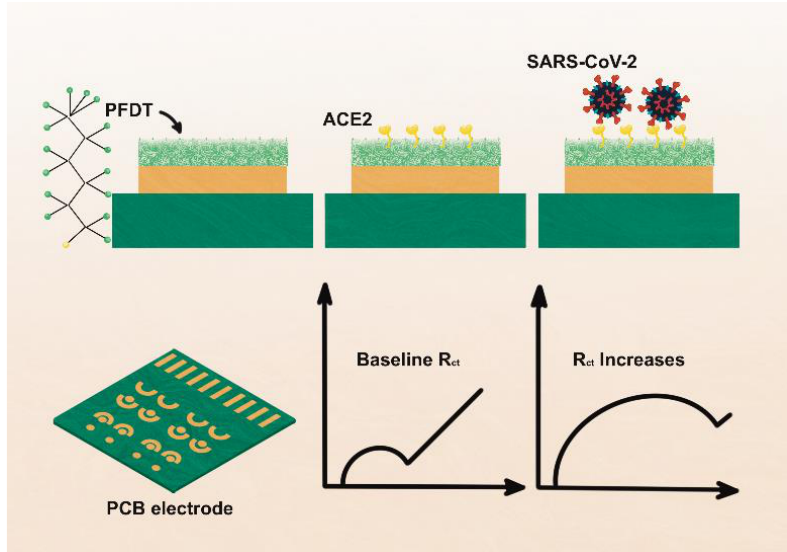
Figure 7. Schematic representation of the fabrication of PFDT-ACE2 biosensor. Top portion shows the sensor fabrication procedure and bottom part shows sensor signals obtained using electrochemical impedance spectroscopy. PFDT, 1H1H,2H,2H-Perfluorodecanethiol; R ct : Charge transfer resistance. Adapted from Ref. [65] with permission from the Royal Society of Chem- istry. This article is licensed under a Creative Commons Attribution 3.0 Unported Licence.